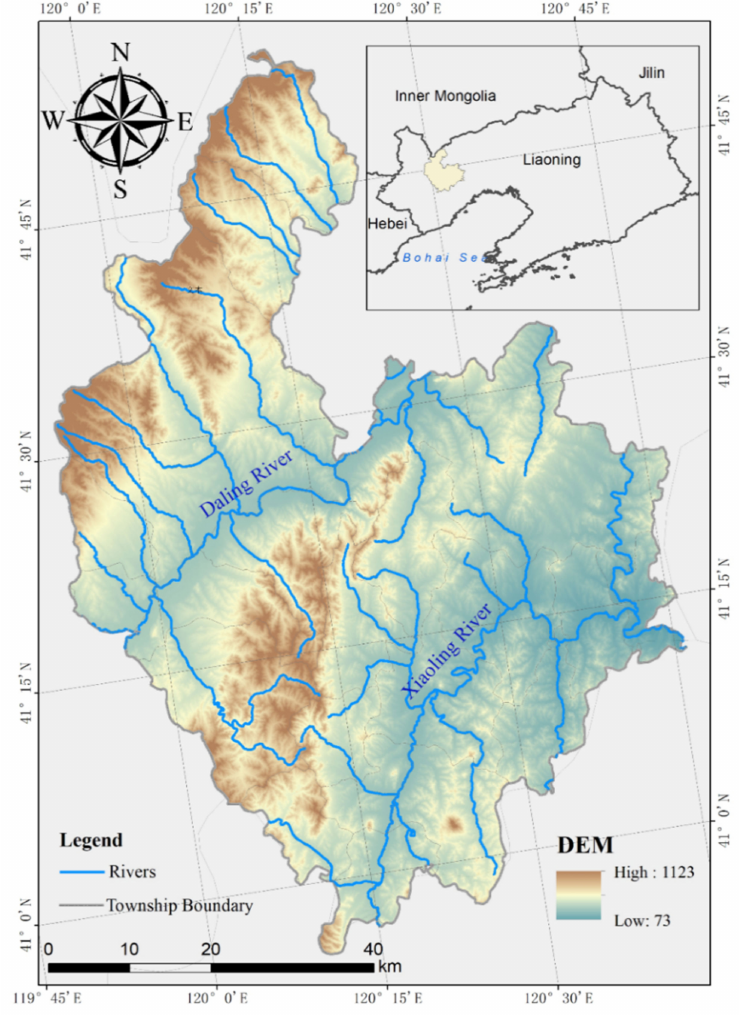
Figure 1. Study Area of Chaoyang